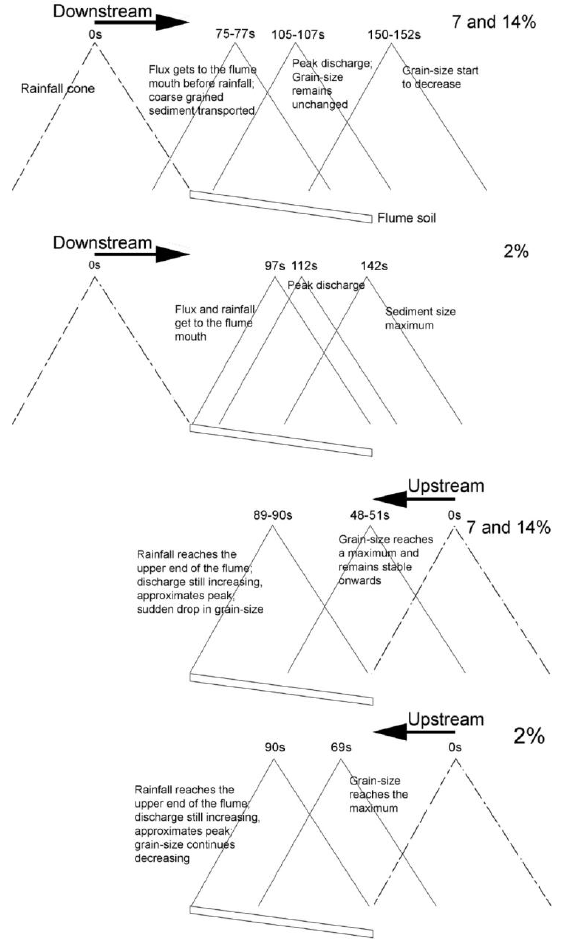
Fig. 6. Schematic representation of the location of the nozzle, in time, with respect to the soil flume, during the experimental procedure, for the two directions of moving storm (downstream and upstream). Milestones of changing-trends in sediment yield grain-size are identified.